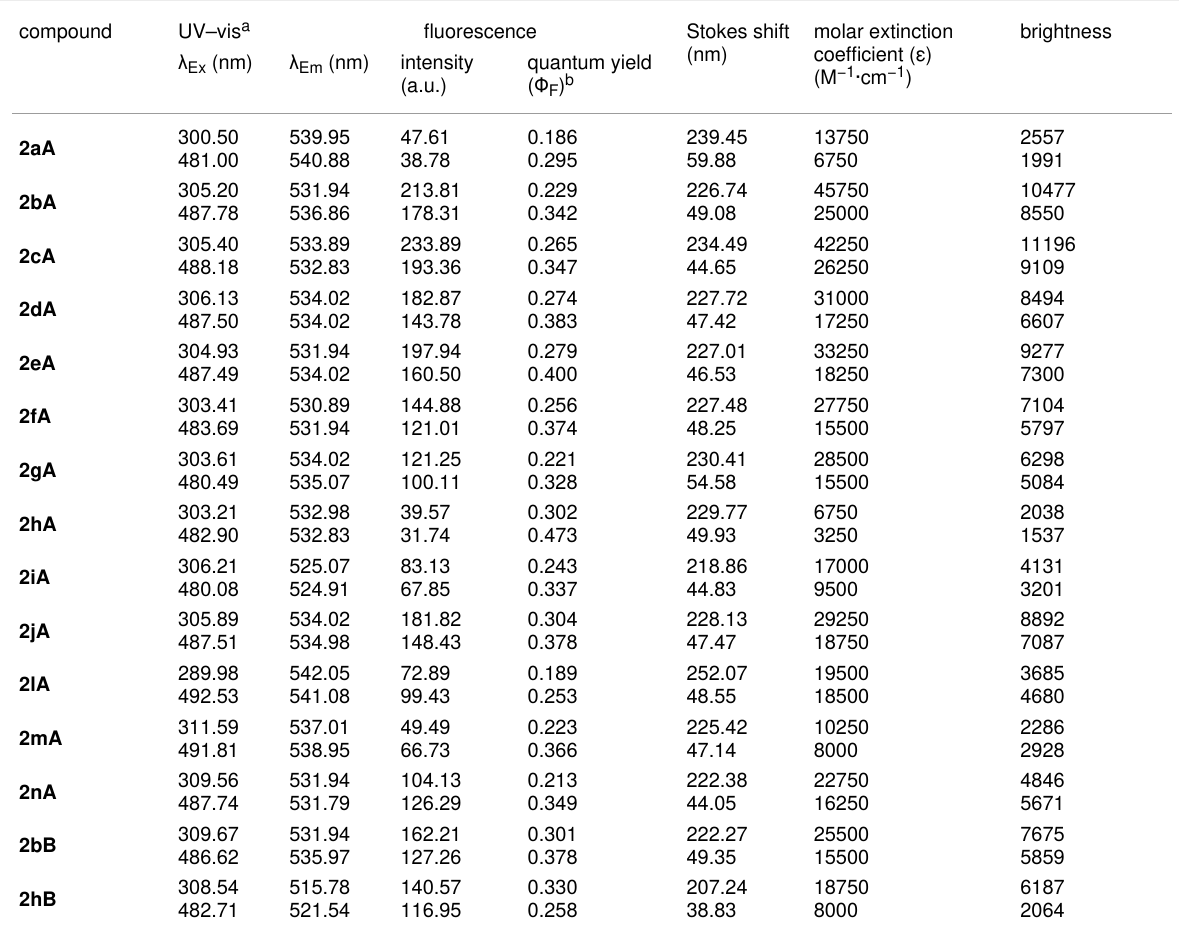
Table 2: Photophysical data of β -carboline-tethered benzothiophenone derivatives.